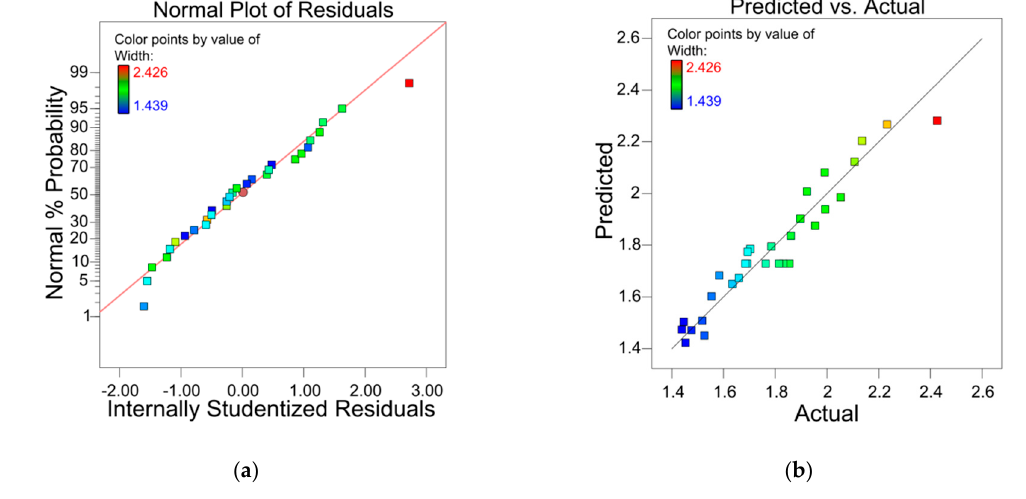
Figure5. ( a )Cladwidthmodelplotofresiduals. ( b Figure 5. ( a ) Clad width model plot of residuals. ( b ) Clad width model prediction and actual comparison.